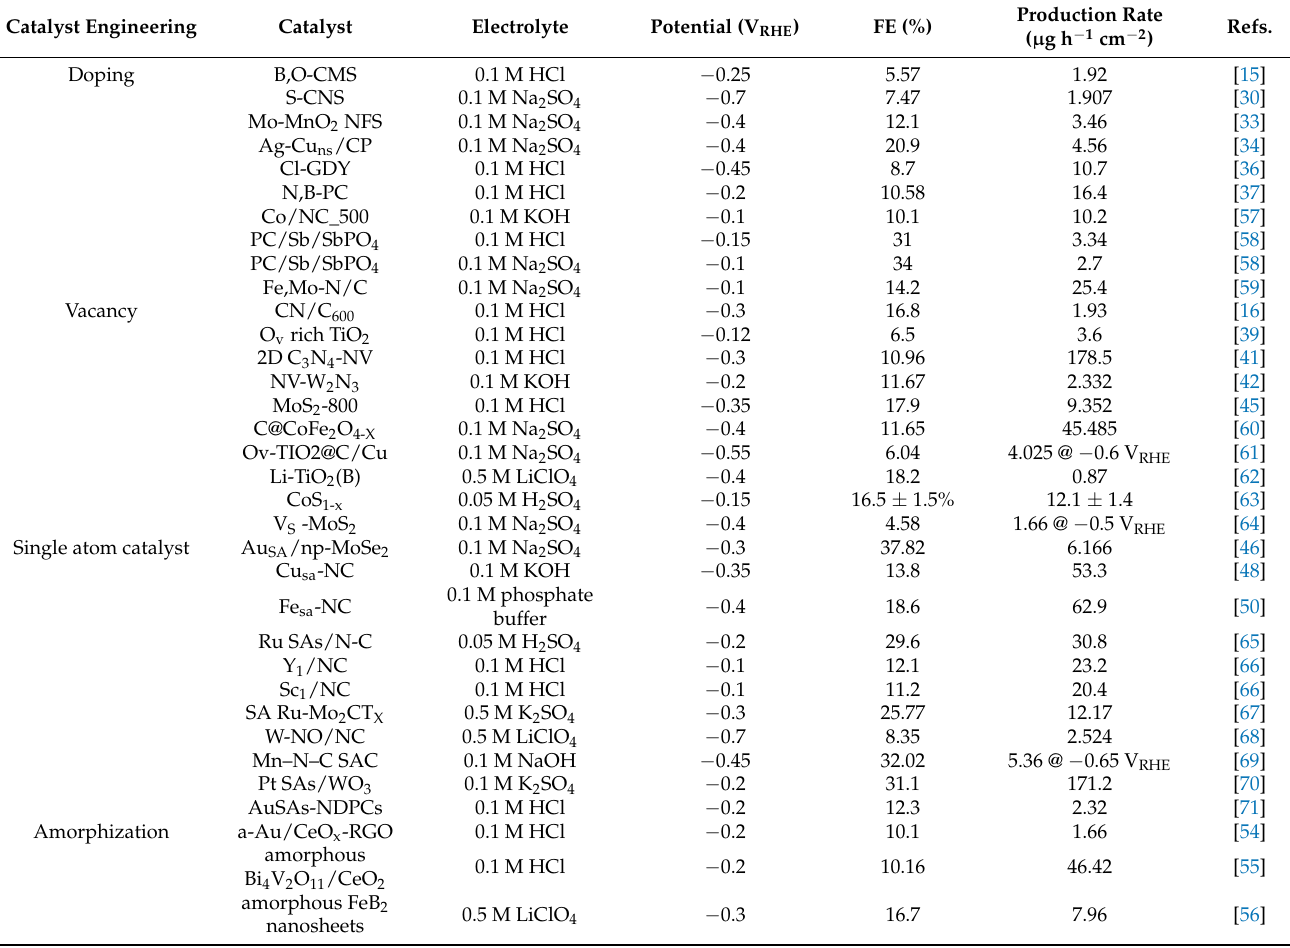
Table 1. A brief summary of experimental studies on ENRR using various electrocatalytic engineering